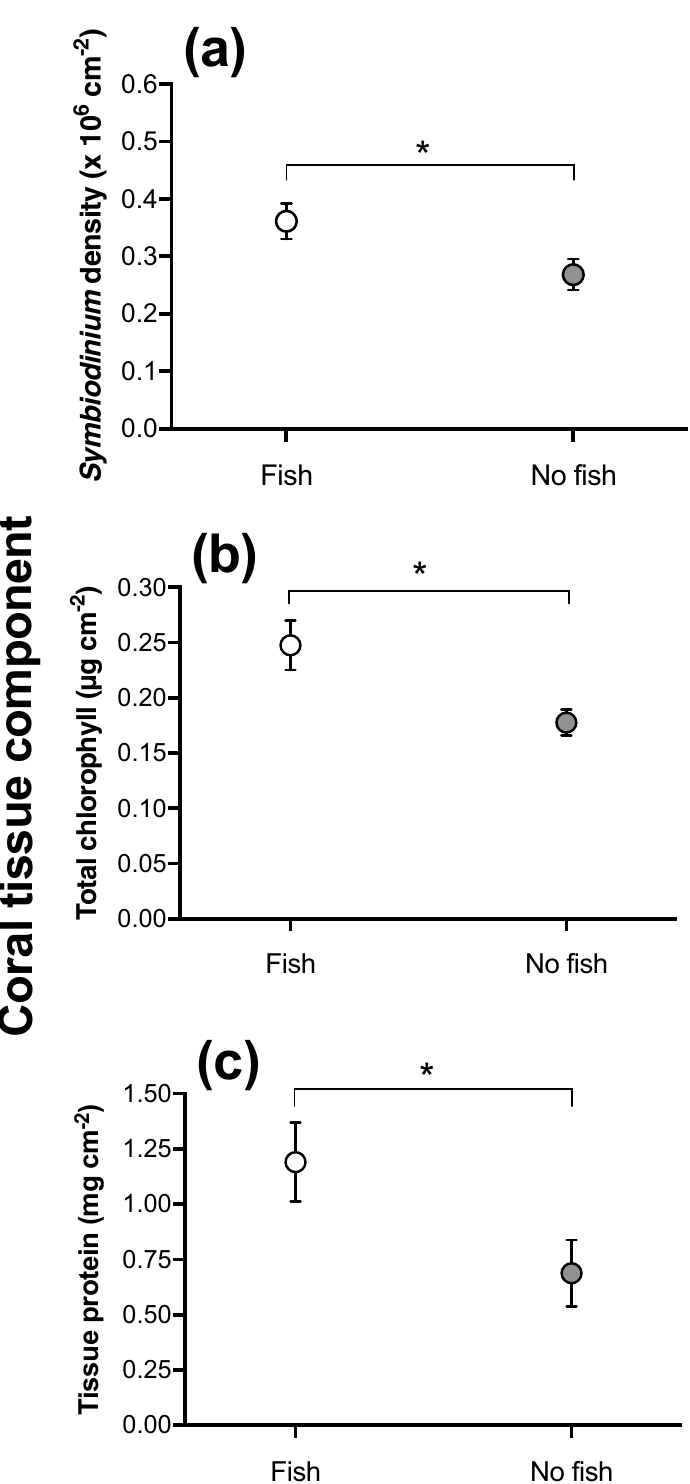
Fig 2. Differences in mean ( ± SE) levels of (a) endosymbionts ( Symbiodinium density x10 6 cm -2 ), (b) total chlorophyll (chl a + chl c , μ g cm - 2 ), and (c) tissue protein (mg cm -2 ) of naturally occurring S . hystrix colonies, with D .